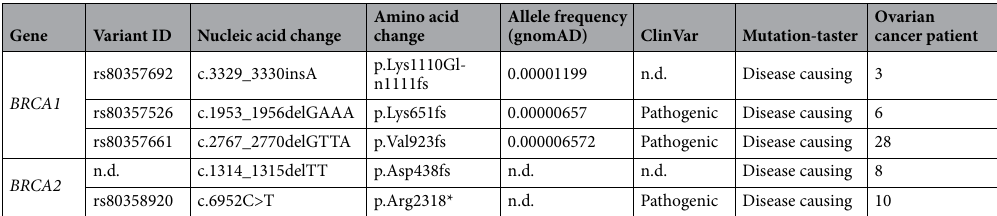
Table 1. Nonsense or frameshift mutations in the HBOC core gene identified by whole-exome sequencing in 29 ovarian cancer